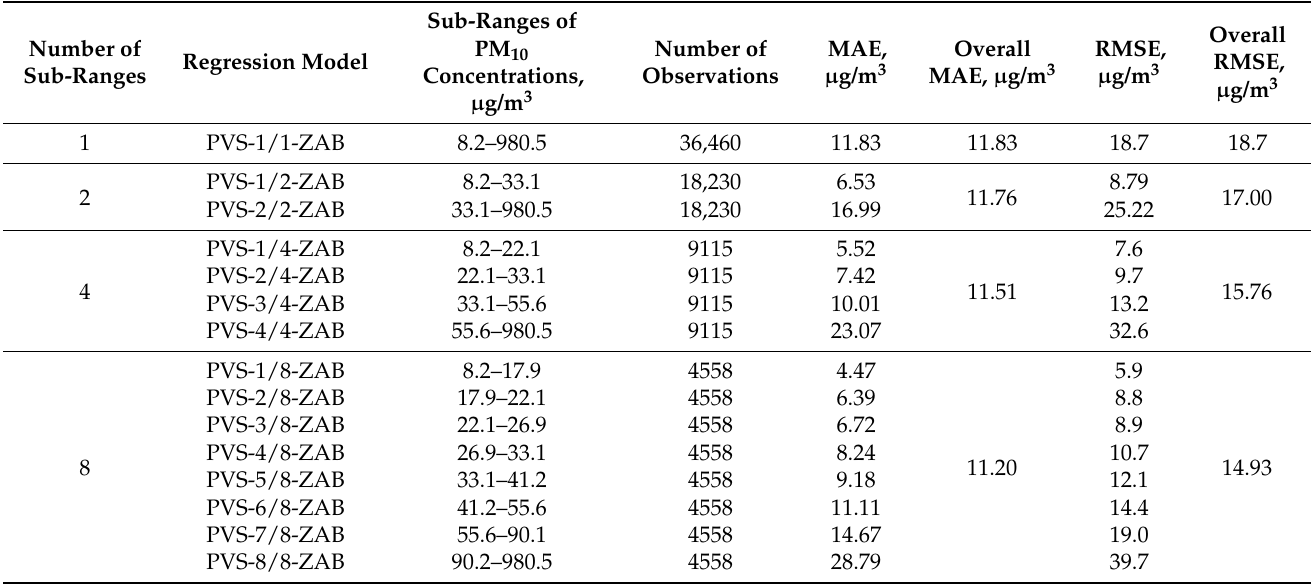
Table 19. Values of approximation errors of PM 10 concentrations in PVS models, Zabrze 2011–2016.